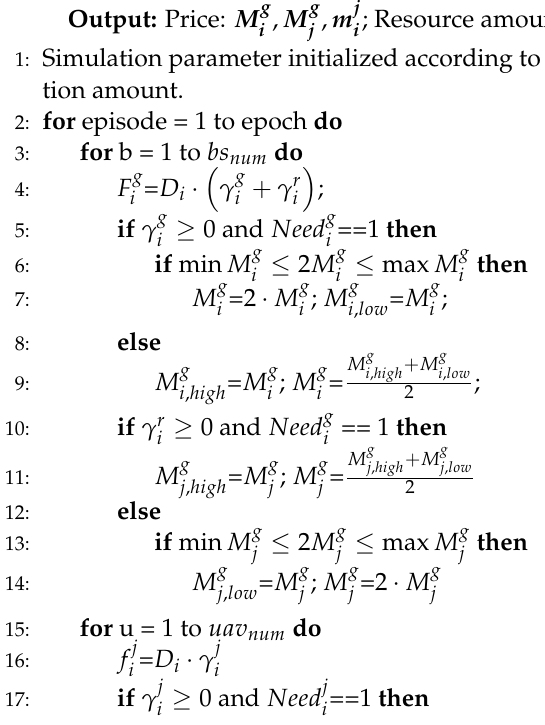
Algorithm 1 Stackelberg game resource pricing and allocation